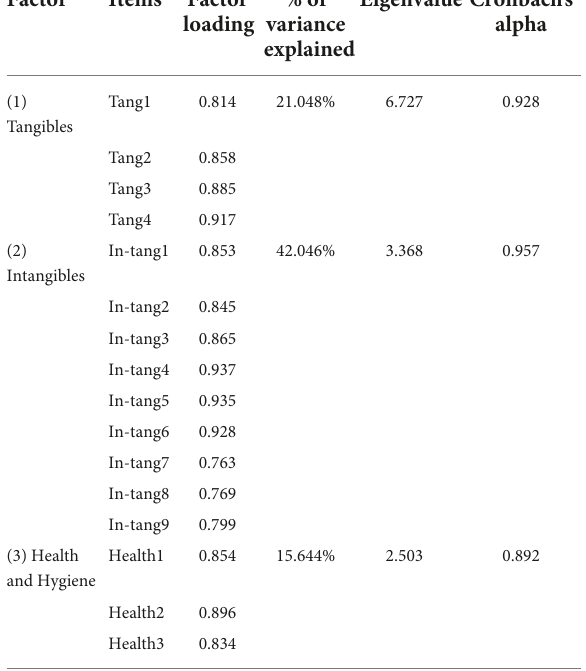
TABLE 2 Exploratory factor analysis (EFA) results of perceived service quality.